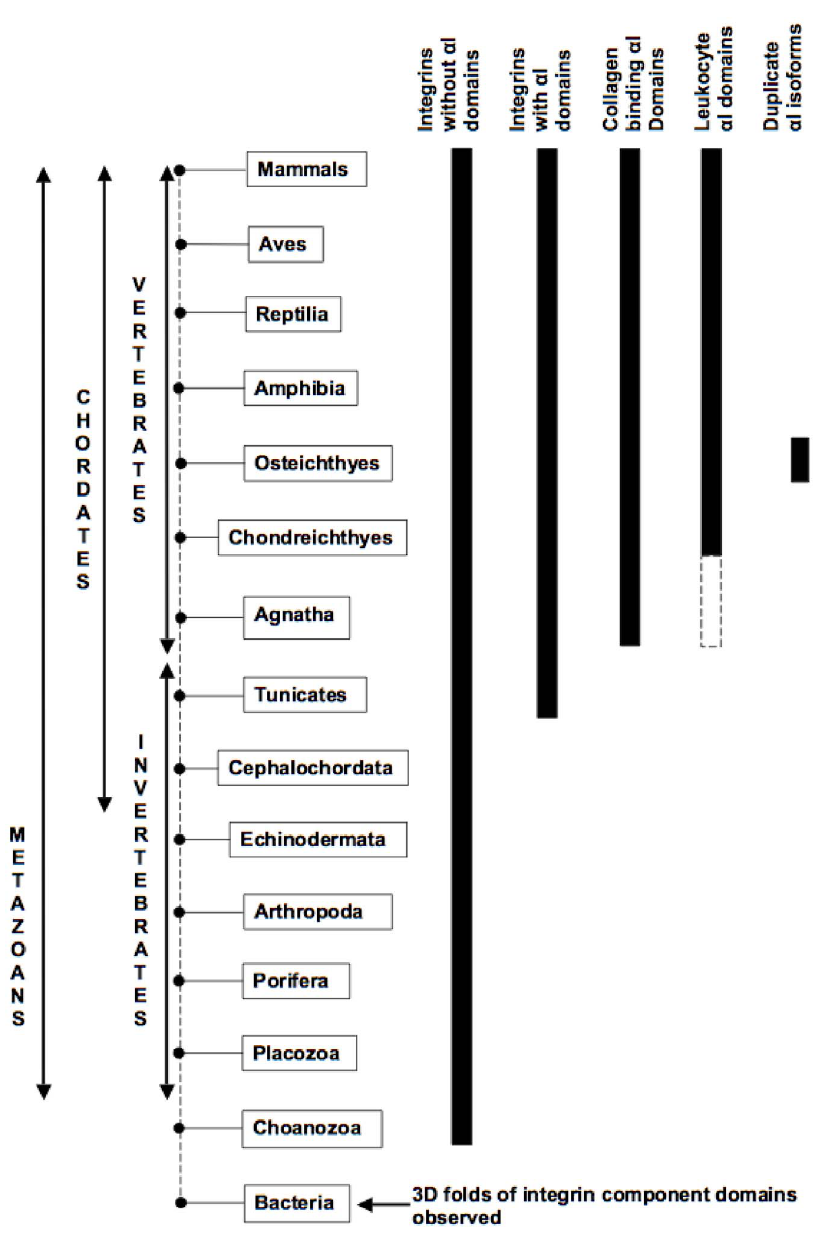
Figure 8. Summary of integrin evolution across a broad range of species: a I domain specialization, as seen in humans, is a vertebrate invention. Individual domains having the same fold class as integrin component domains (i.e. b propeller, immunoglobulin fold, epidermal growth factor fold, vWFA) are observed already in prokaryotes but the earliest diverging sets of identifiable integrin subunits have been observed in the choanozoan C. owczarzaki , a single-cell eukaryote. The number of a and b subunits expands with increasing organismal complexity with 18 a and 8 b subunits forming up to 24 heterodimers in humans. Integrins undergo considerable functional diversification with the introduction of the a I domain in some a subunits. Tunicates like C. intestinalis and H. roretzi are the earliest diverging organisms where integrins with a I domains have been identified, but they are not direct vertebrate orthologues as they form a distinct clade. a I domain containing fragments can be detected in the lamprey P. marinus and possibly the hagfish E. burgeri ; both are extant representatives of the first vertebrates. The lamprey fragments share characteristic features in common with the human collagen-binding a I domain group and they bind different mammalian collagens at MIDAS; four shark sequences are orthologues of the corresponding human a subunits, three collagen binding and one from the leukocyte clade, and duplicate isoforms are observed in observed in bony fish e.g. D. rerio , C. carpio and O. niloticus .